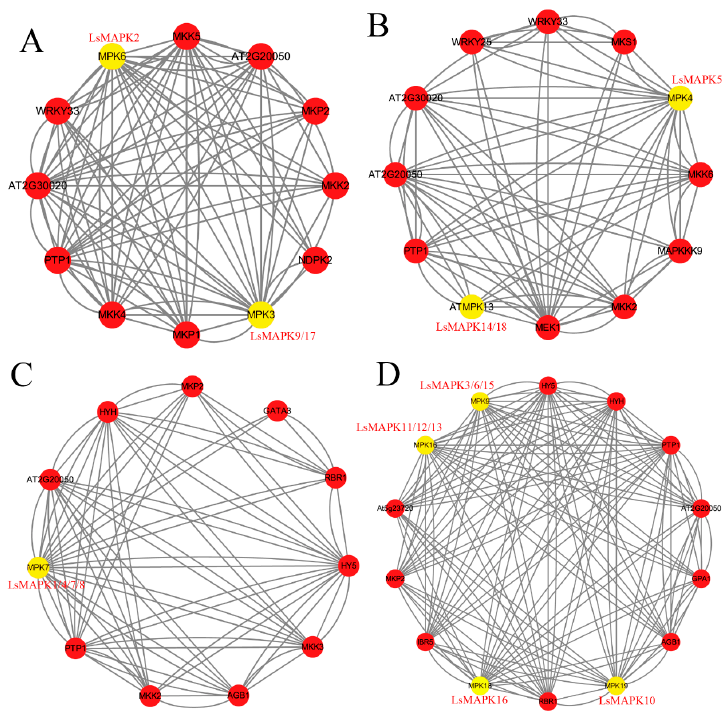
Figure 7. An interaction network analysis of LsMAPK proteins. ( A ) Interaction proteins of LsMAPK proteins belonging to the Group A subfamily. ( B ) Interaction proteins of LsMAPK proteins belonging to the Group B subfamily. ( C ) Interaction proteins of LsMAPK proteins belonging to the Group C subfamily. ( D ) Interaction proteins of LsMAPK proteins belonging to the Group D subfamily.